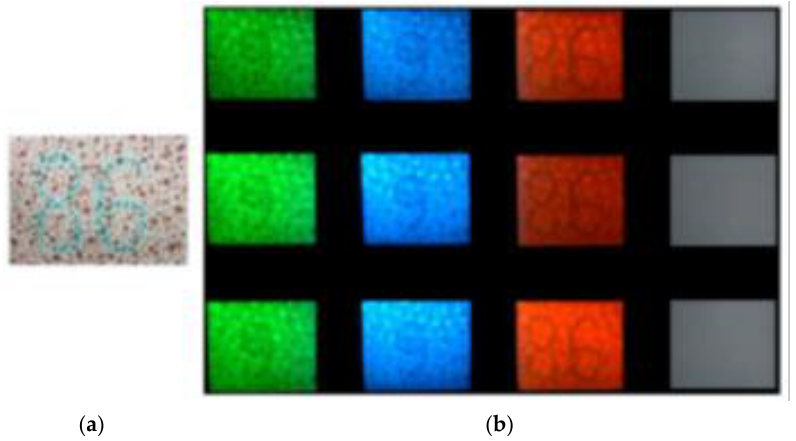
Figure 45. MSI: ( a ) color blindness test card and ( b ) imaging results.